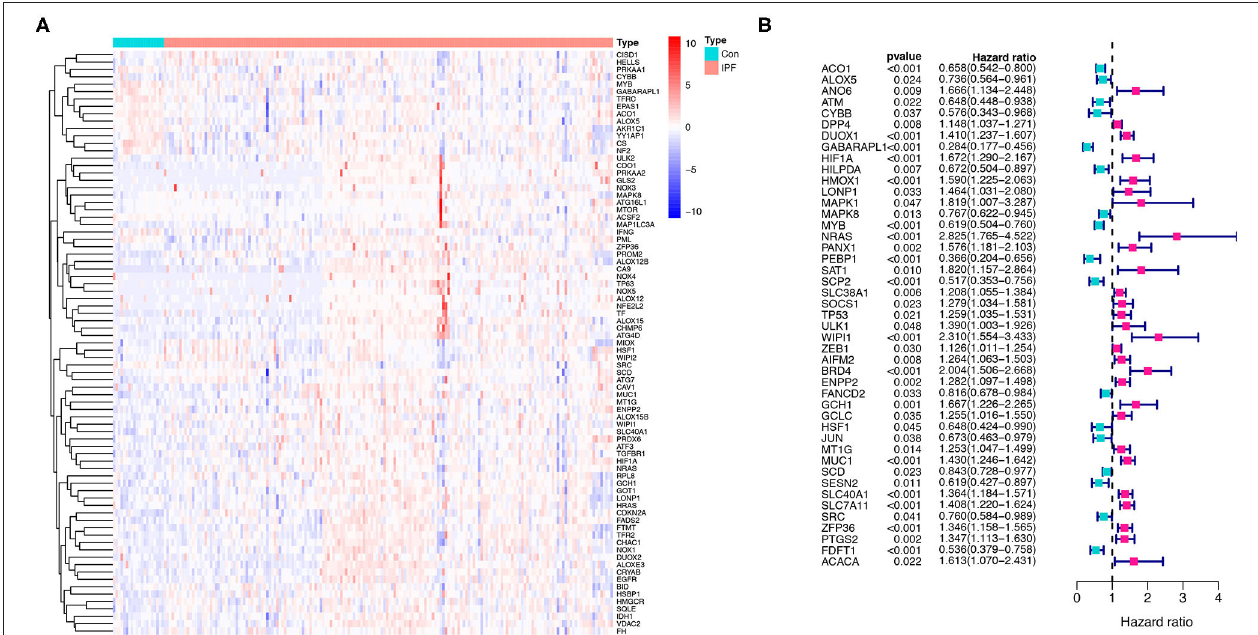
FIGURE 2 | Identification of the FRGs in the patients with IPF from the Gene Expression Omnibus (GEO) database. (A) The expression of the 79 ferroptosis-related DEGs in IPF. (B) The 45 ferroptosis-related prognostic genes in IPF. p < 0.05 was considered significant. FRGs, ferroptosis-related genes; IPF, idiopathic pulmonary fibrosis; and DEGs, differentially expressed